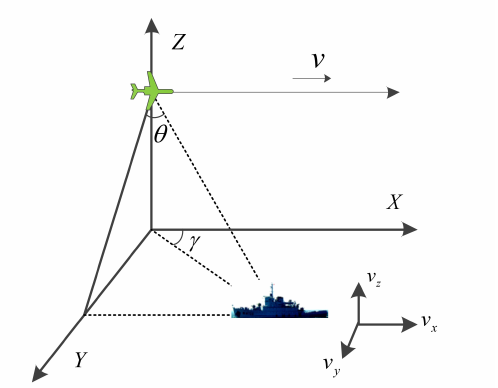
Figure 6. Geometric model of ship target imaging using the mobile platform SAR.